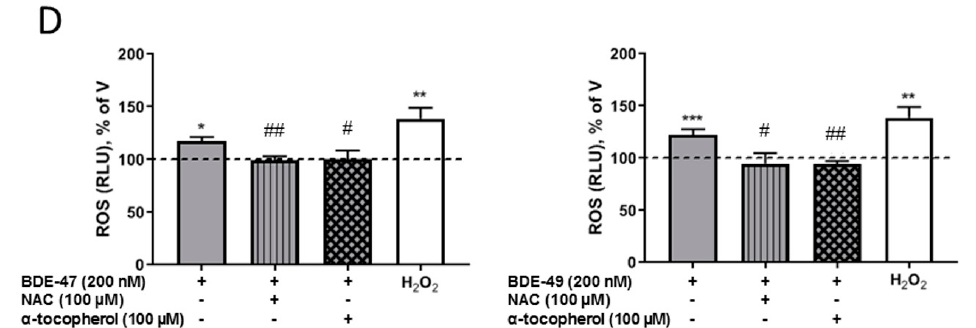
Figure 3. Antioxidants prevented BDE-47 and BDE-49 inhibition of axonal growth and production of ROS. Primary neuron-glia co-cultures dissociated from the hippocampi of P0-1 rat pups were exposed to vehicle, BDE-47 or BDE-49 in the absence or presence of N-acetyl cysteine (NAC) or α -tocopherol. After 48 h exposure, cultures were fixed and immunostained for tau-1. ( A ) Representative photomicrographs of DIV 2 hippocampal neurons from different experimental groups. Scale bar = 25 µm. ( B ) Quantification of axon length in tau-1 immunopositive cells ( n = 70–90 neurons from three inde- pendent dissections). Quantification of ROS levels following exposure to vehicle, BDE-47 or BDE-49 alone ( C ) or in the presence of an antioxidant ( D ) ( n = three independent dissections). H 2 O 2 was in- cluded as a positive technical control for the ROS-Glo assay per the manufacturer’s instructions. Data presented as the mean ± SE. * Significantly different from vehicle at * p < 0.05, ** p < 0.01, *** p < 0.001, **** p < 0.0001; # significantly different from PBDE treatment alone at # p < 0.05, ## p < 0.01, as deter- mined by one-way ANOVA followed by Tukey’s post hoc test; †significantly different from individual PBDE treatment at p < 0.05 as determined by Student’s t